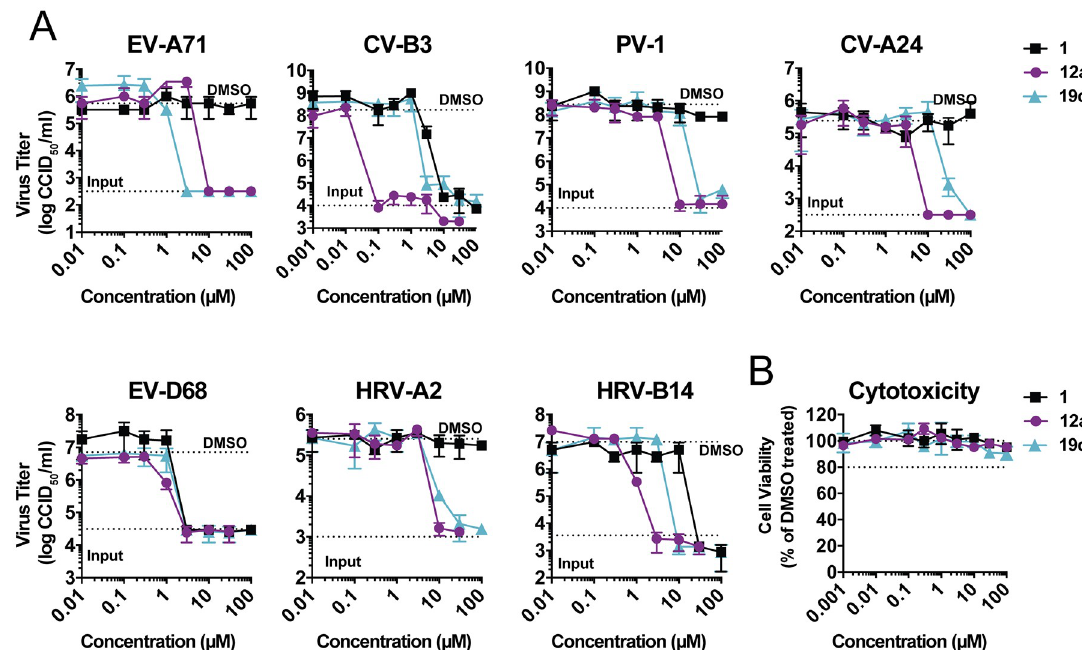
Fig 2. Antiviral efficacy of compound 1, 12a, and 19d against a panel of EVs. (A) In a single-cycle viral replication assay, HeLa R19 cells were infected with EV-A71 (strain BrCr), CV-B3 (strain Nancy), PV-1 (strain Sabin), CV-A24 (strain Joseph), EV-D68 (strain Fermon), HRV-A2, and HRV-B14 at MOI 1. At 30 minutes after infection, the cells were treated with serial dilutions of the parental compound 1 and the analogues 12a and 19d. Eight hours (EV-A71, CV-B3, PV-1, CV-A24) or ten hours (EV-D68, HRV-2, HRV-14) post infection, cells were freeze-thawed three times, and virus titers of lysates were determined by endpoint dilution. (B) In parallel, uninfected cells were treated with compounds only, and cell viability was determined using an MTS assay. Data represent mean ± SD from one representative experiment. Every experiment was performed in biological triplicates, and two independent experiments were performed. All underlying experimental data are displayed in S2 Data. CCID 50 , cell culture infectious dose; CV, coxsackievirus; EV-A71, enterovirus A71; EV-D68, enterovirus D68; HRV, human rhinovirus; MOI, multiplicity of infection; MTS, 3-(4,5-dimethylthiazol-2-yl)- 5-(3-carboxymethoxyphenyl)-2-(4-sulfophenyl)-2H-tetrazolium; PV-1, poliovirus 1.